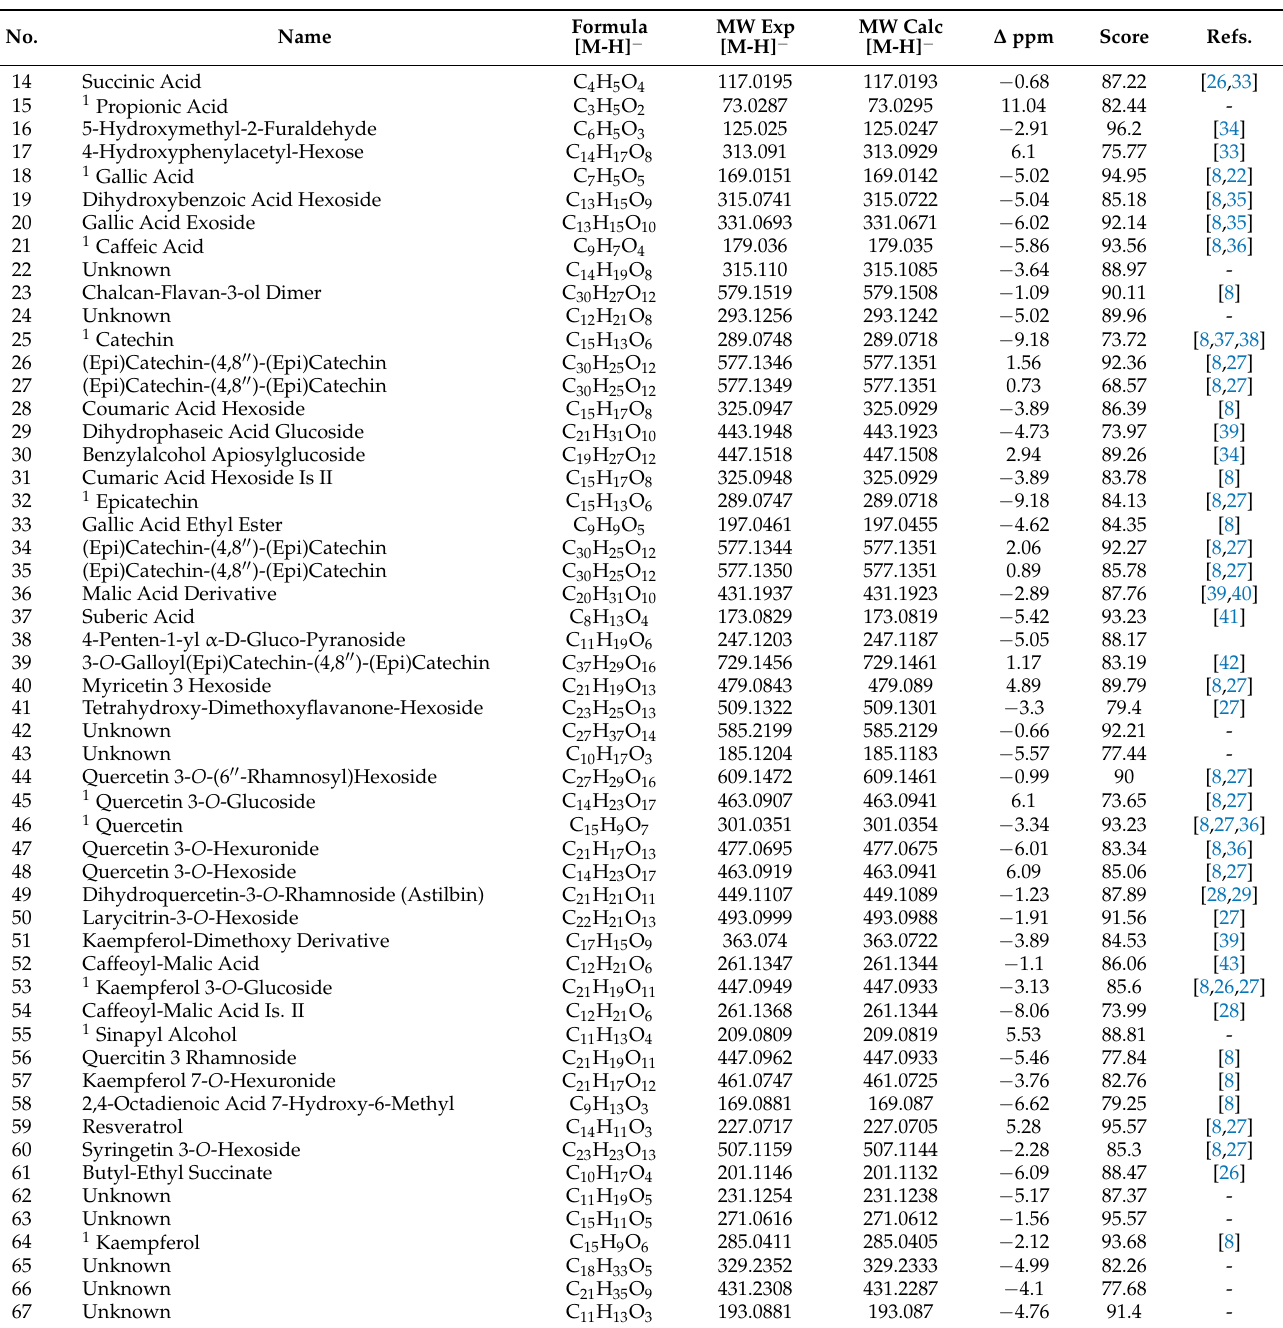
The quantification of the most representative polyphenolic compounds is shown in Table 5. The highest concentration values were observed for catechin and epicatechin, followed by the glucosides of quercetin and kaempferol. In particular, the catechin content ranged between 0.45 and 2.54 mg/g DW in Malvasia di Lecce and Primitivo, respectively. The epicatechin concentration was 1.95 mg/g in Primitivo grape marc, whereas it was 0.25 mg/g in Malvasia di Lecce. Regarding the flavonol compounds, the most abundant were the quercetin derivatives, in particular the quercetin glucuronide ranging from 0.05 (Primitivo) to 0.91 mg/g DW (Malvasia di Lecce). Negramaro grape marc showed a